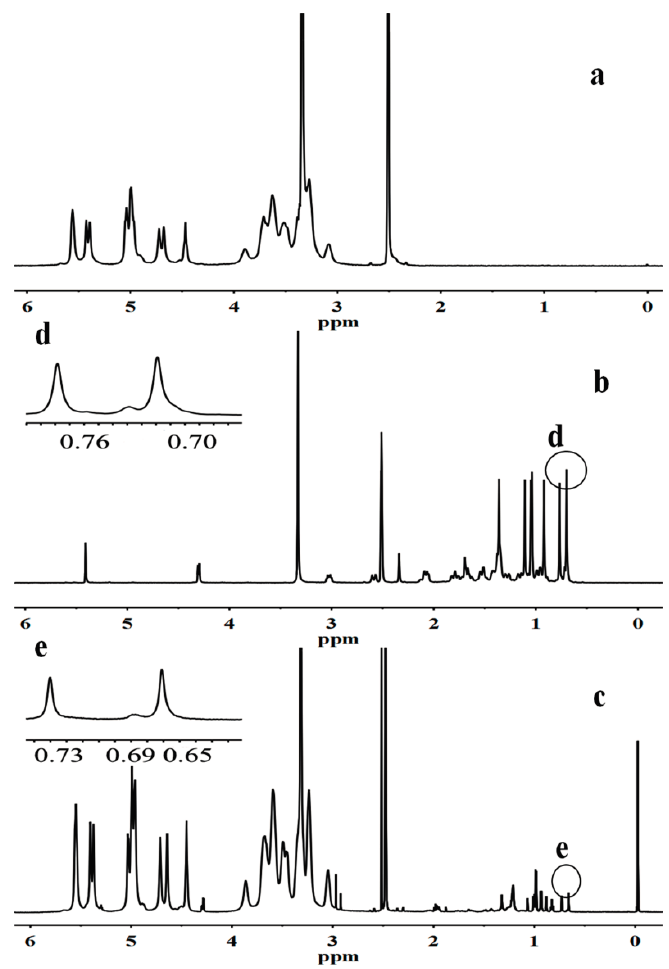
Figure 2. 1 H-NMR spectra for ( a ) pullulan, ( b ) GA, ( c ) GAP, ( d ) and ( e ) the angular methyl of C and C 23 24